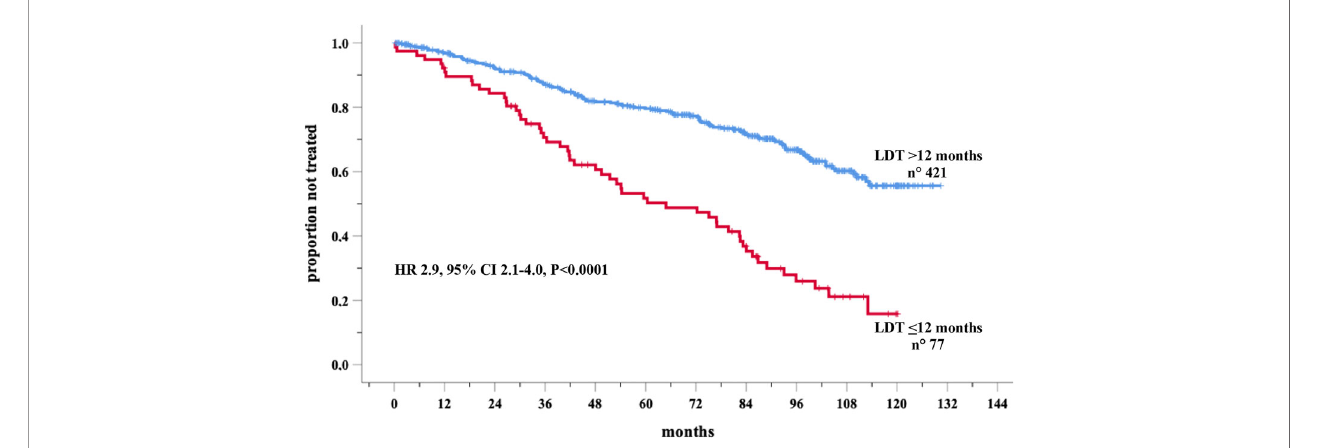
FIGURE 1 | Kaplan-Meir curves of time to fi rst treatment (TTFT) of patients strati fi ed by lymphocyte doubling time (LDT) in the O-CLL training